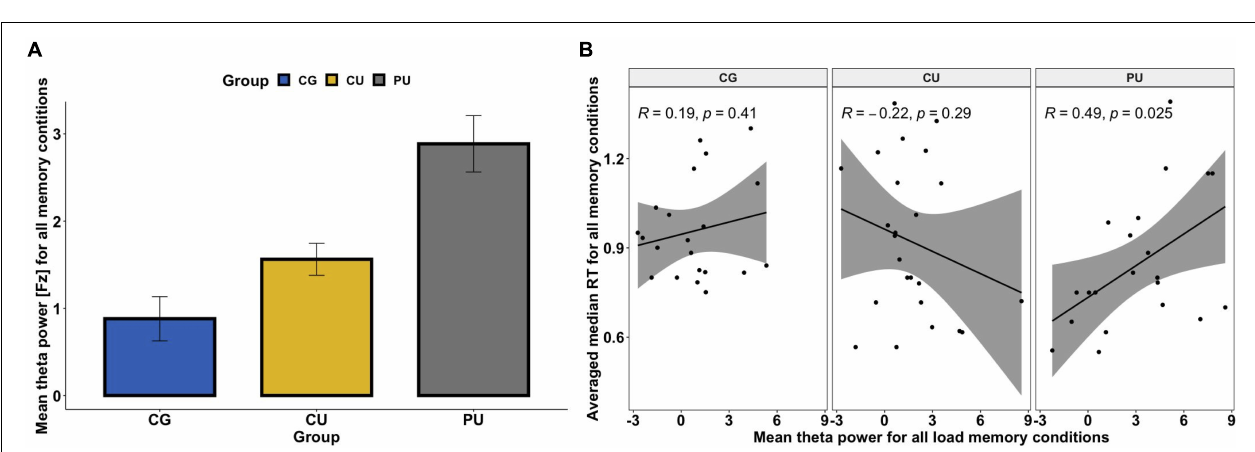
FIGURE 3 | (A) Mean absolute theta (4–8 Hz) power for all memory loads for control group (CG), cannabis users (CU) and polydrug users (PU). There were significant differences between CG and PU ( p < 0.05). No significant load effect was observed for the frontal midline (FM) theta power. (B) Association between mean theta power (Fz) averaged across all memory loads and averaged reaction time across all memory conditions (for correct answers only) for each group